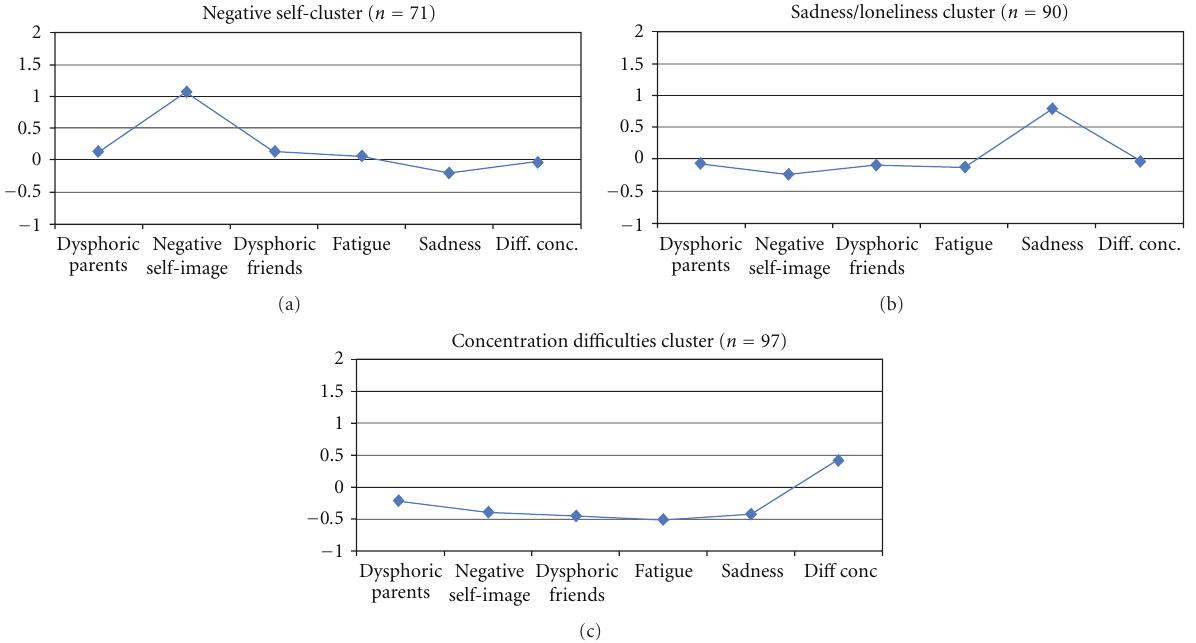
Figure 3: One-problem clusters. Profiles in terms of z -scores (where z = 0 corresponds to the whole sample’s mean on each subscale). between depressive symptoms and self-harm in the